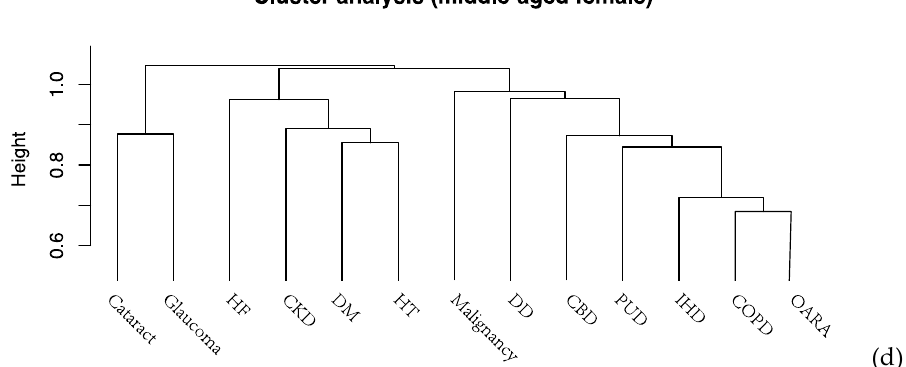
Figure 2. Dendrograms of cluster analysis showing the distribution and aggregation of chronic diseases in ( a ) middle-aged males, ( b ) middle-aged females, ( c ) older males, and ( d ) older females.